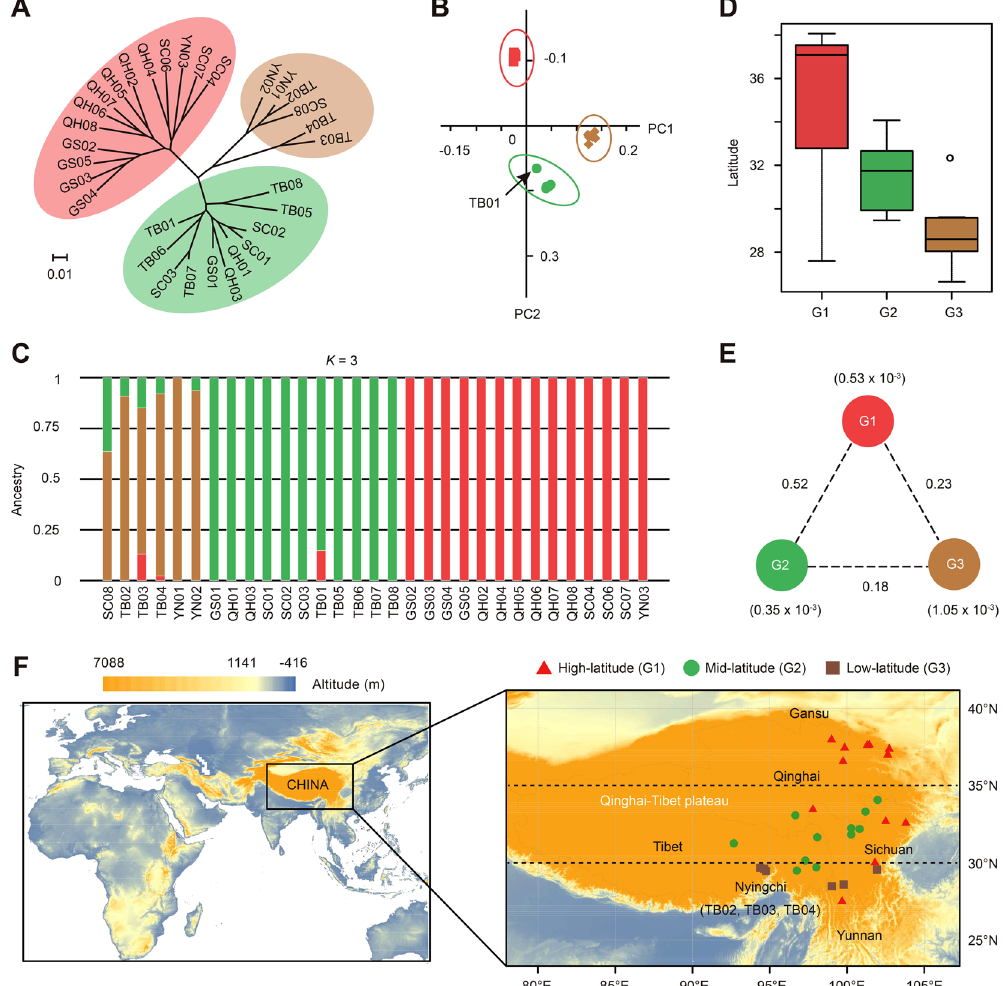
Figure 4. Latitude-based population divergence of O . sinensis . ( A ) Neighbor-Joining (NJ) phylogenetic tree of 31 O . sinensis accessions constructed using SNP data. The scale bar represents the evolutionary distances measured by p -distance. ( B ) Two-way principal components analysis (PCA) using identified SNPs. The leading five eigenvectors explain 71.4% variance with 34.5% by eigenvector 1 and 20.1% for eigenvector 2 (Supplemental Figure S20A). ( C ) Population structure of O . sinensis . Each color and vertical bar represents one population and one accession, respectively. The y-axis shows the proportion of each accession contributed from ancestral populations. ( D ) Latitude distribution for the three inferred groups (G1, G2 and G3). The longitude, latitude and altitude for each population were determined by GPS when collecting samples in the field (Supplemental Table S37). ( E ) Nucleotide diversity and population divergence across the three groups. Values in parentheses indicate the nucleotide diversity ( π ) for groups, while values between pairs represent the population divergence measured by F ST . ( F ) Geographic distribution of the 31 O . sinensis populations and their latitude-based divergence. The maps are generated using ArcGIS software (version 10.1; https://www.arcgis.com/features/